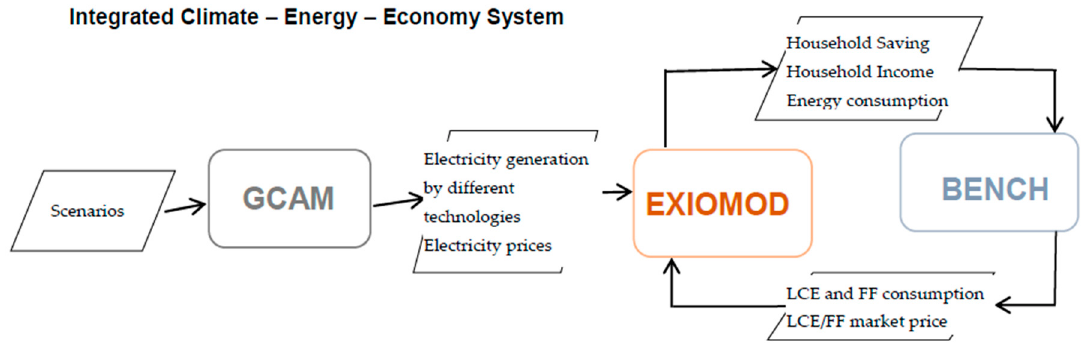
Figure 3. Conceptual design of the integrated climate-energy-economy